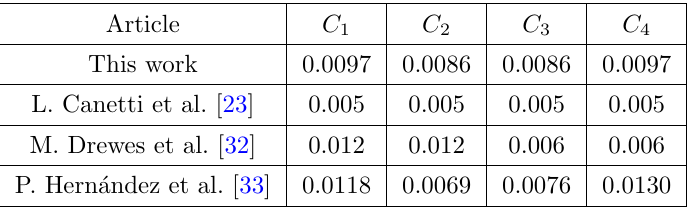
Table 2 . The coe(cid:14)cients of the rates in considered works.